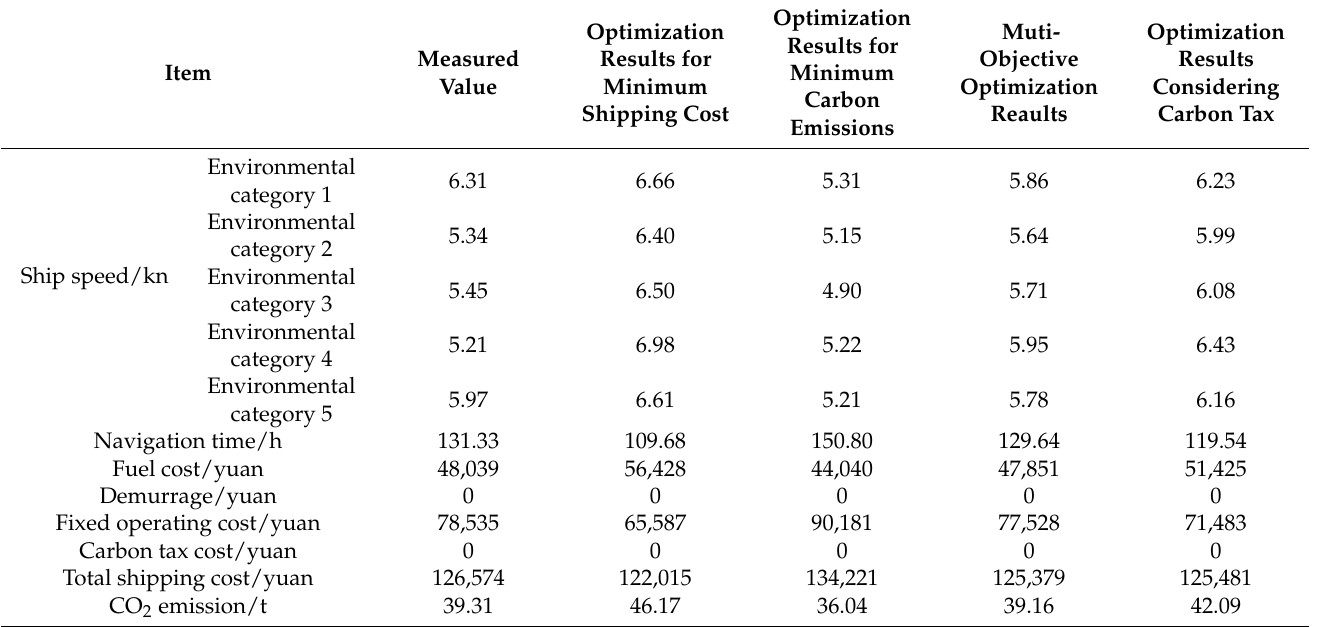
Table 4. Multi-objective optimization Table 4. Multi ‐ objective optimization results.